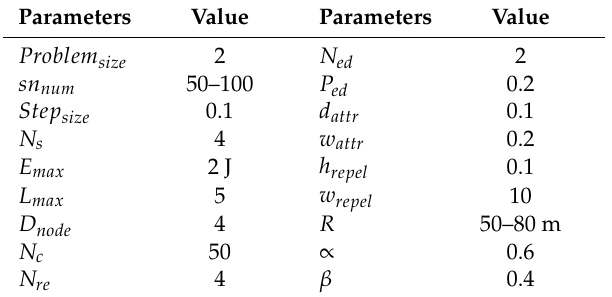
Table 6. List of the other parameters used in the proposed